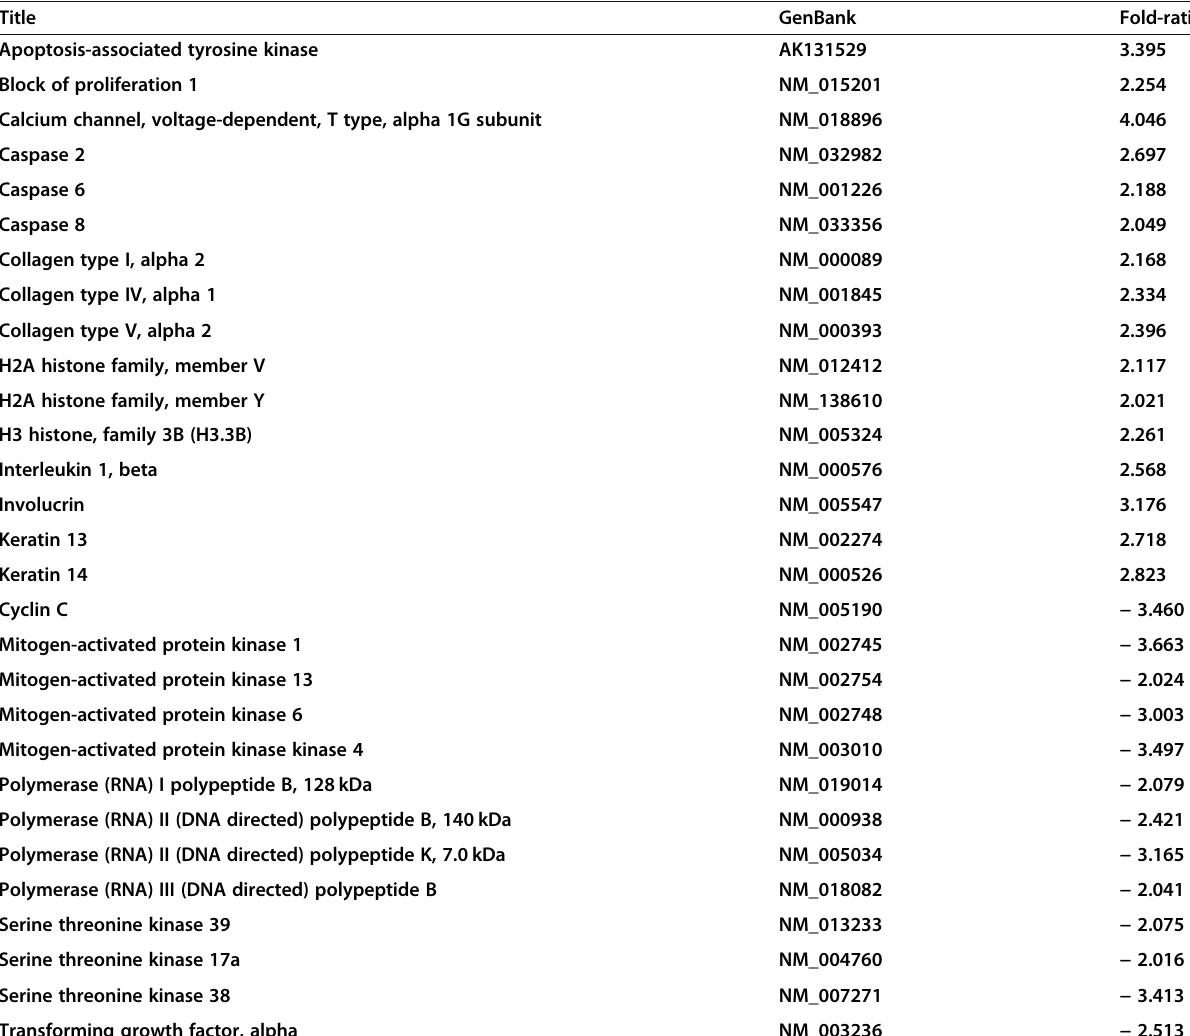
Table 2 The results of cDNA microarray. The genes of interest were shown among the genes which showed significant changes at 12 h after 4HR application (10 μ